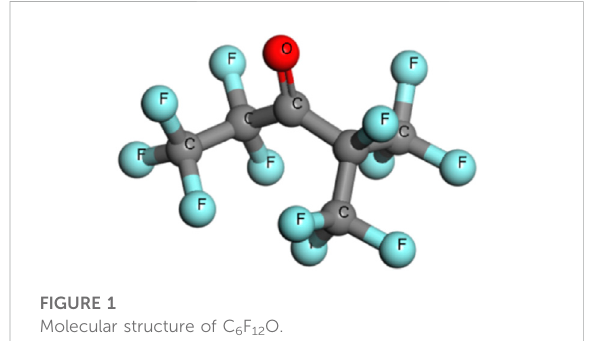
FIGURE 1 Molecular structure of C 6 F 12